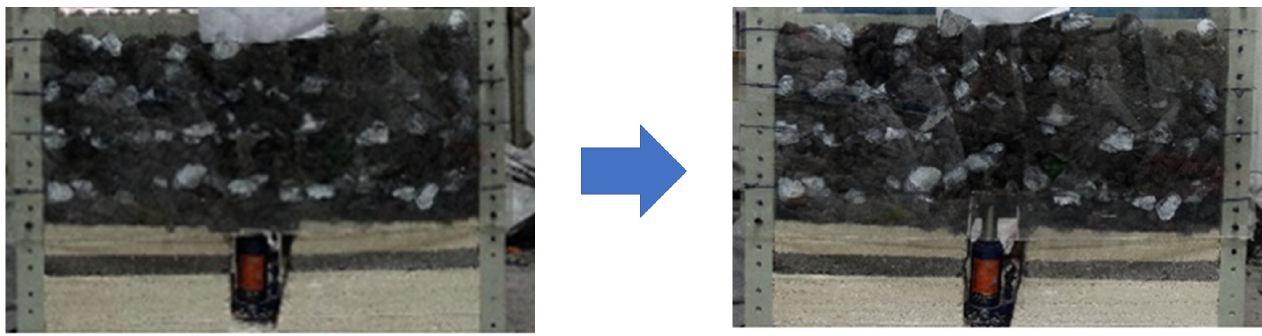
Figure 2. Similar simulation device and collapse body sample.